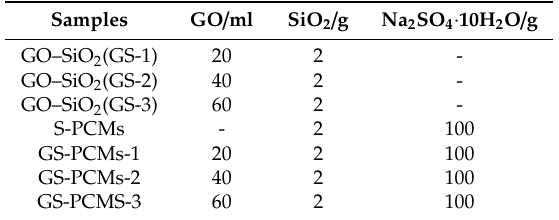
Table 1. Mix composition of the GO–SiO 2 composites and the composite phase change materials